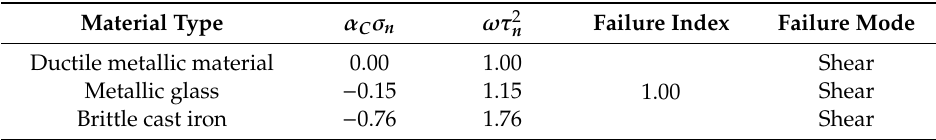
Table 3. Failure modes under uniaxial